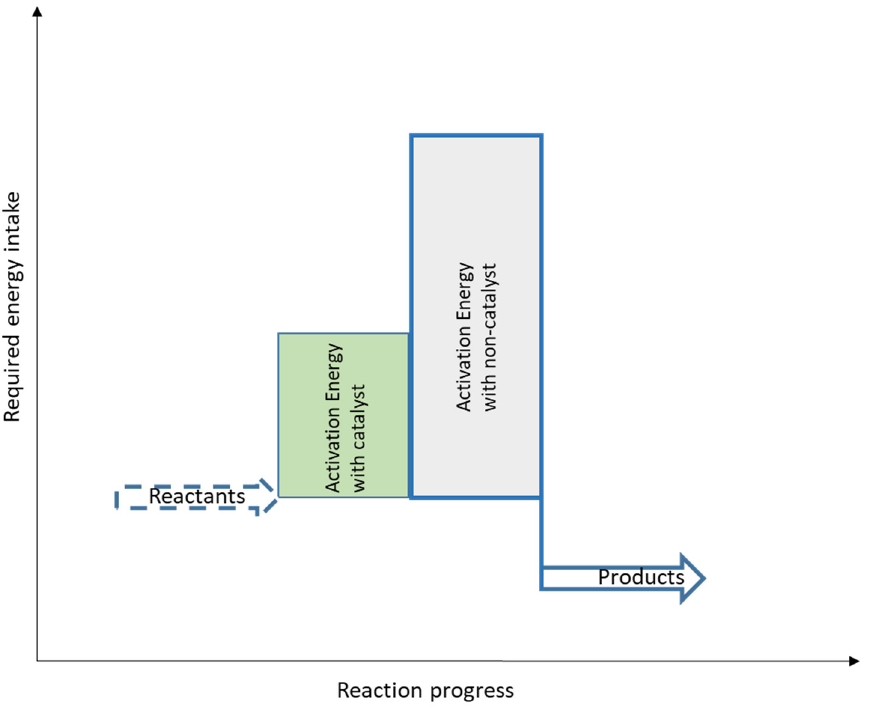
Figure 1. Activation energy profile- Maxwell-Boltzmann distribution curve.